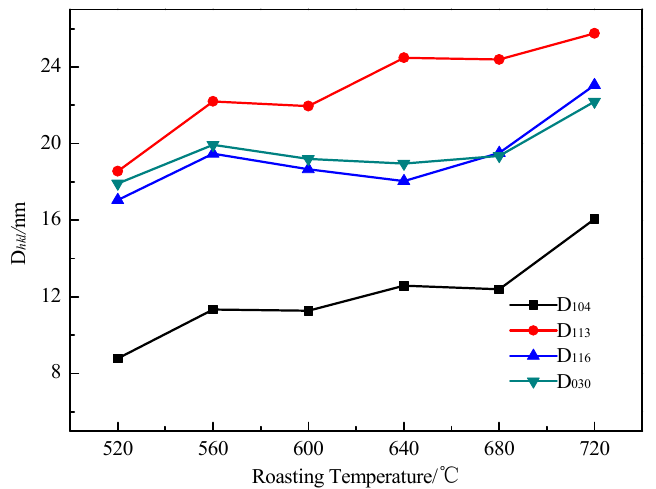
Figure 10. The trend of α‐ Al 2 O 3 microcrystallite size change in ore roasted at varying tempera ‐ tures.